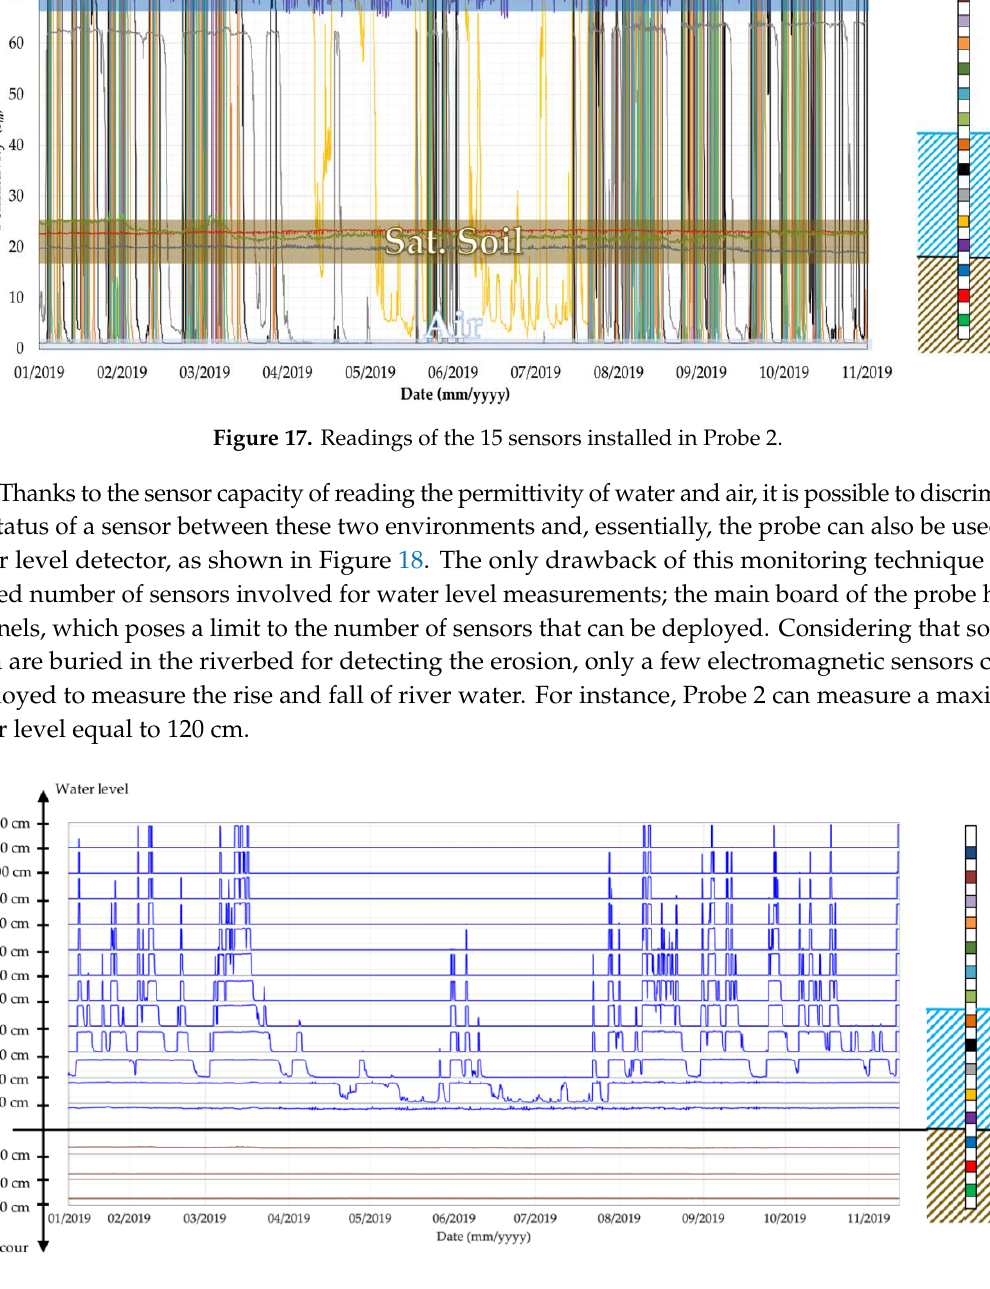
Figure 18. Rise and fall of water detect by the sensors of Probe 2.